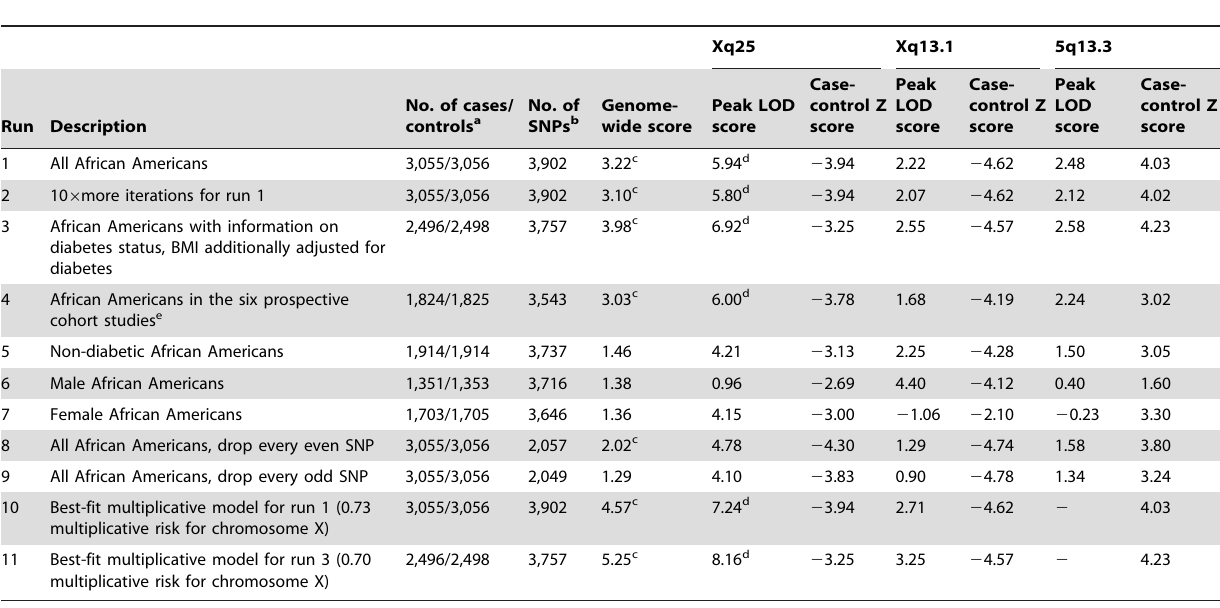
Table 2. Summary of results from dichotomous admixture scans for BMI.